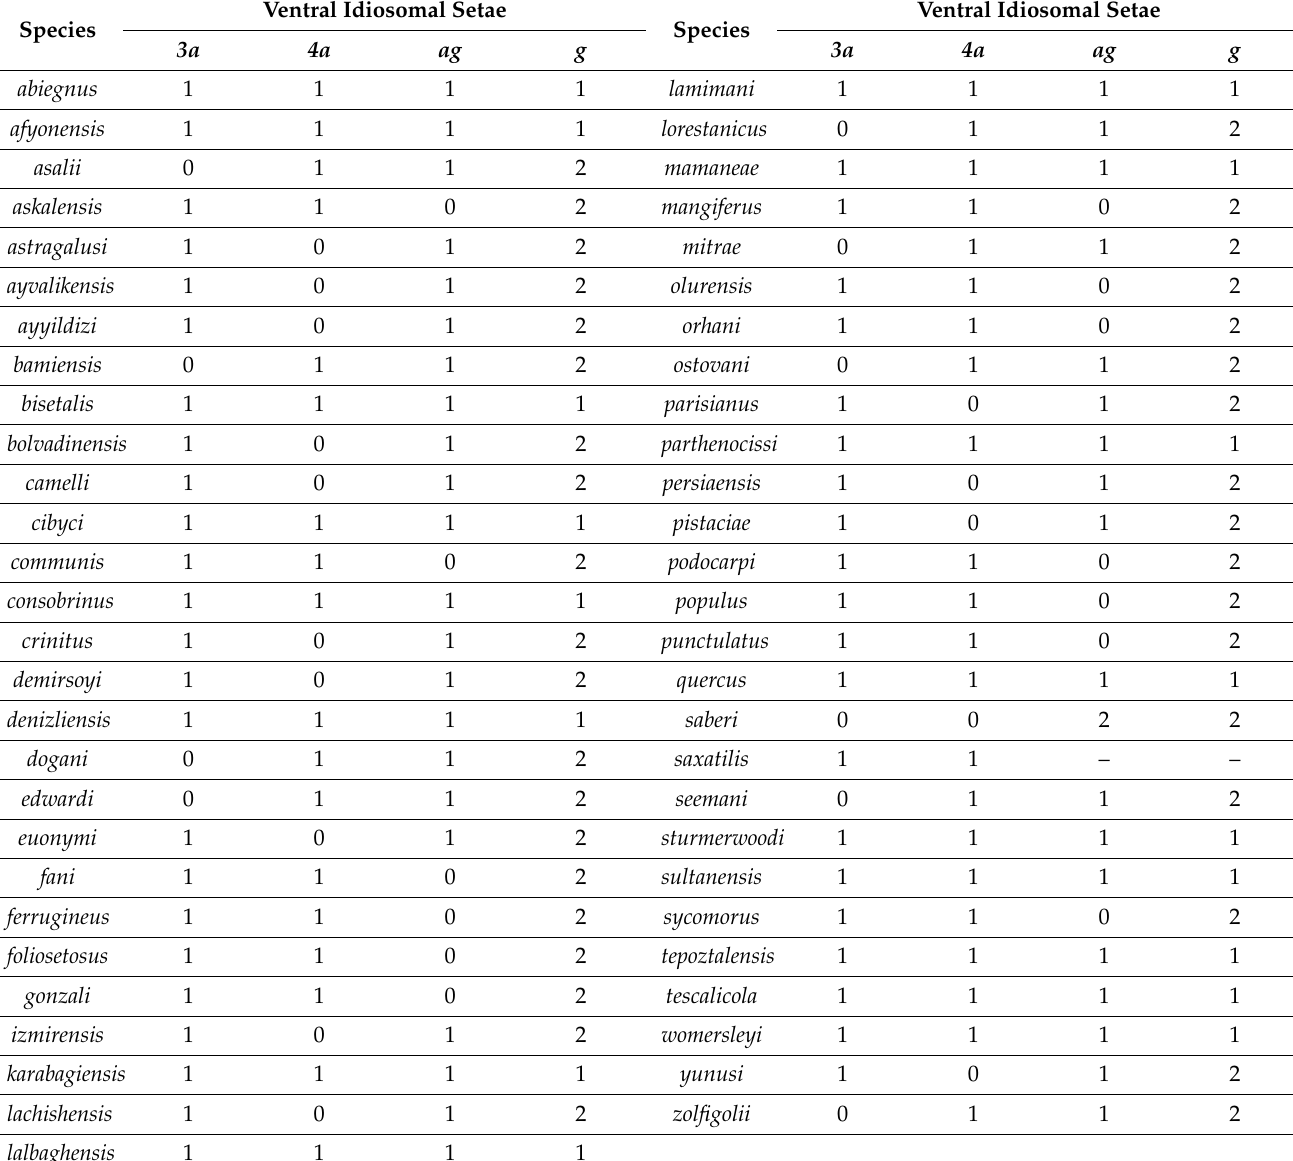
Table 3. Ventral idiosoma setal notation described and illustrated in 55 species of Neophyllobius